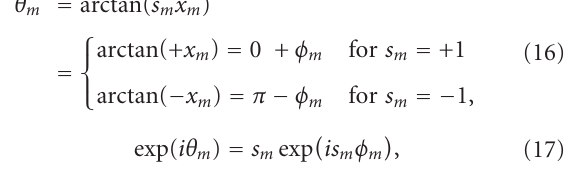
going (of a complex amplitude marked by superscript − ) with respect to the axis z directed transversely to